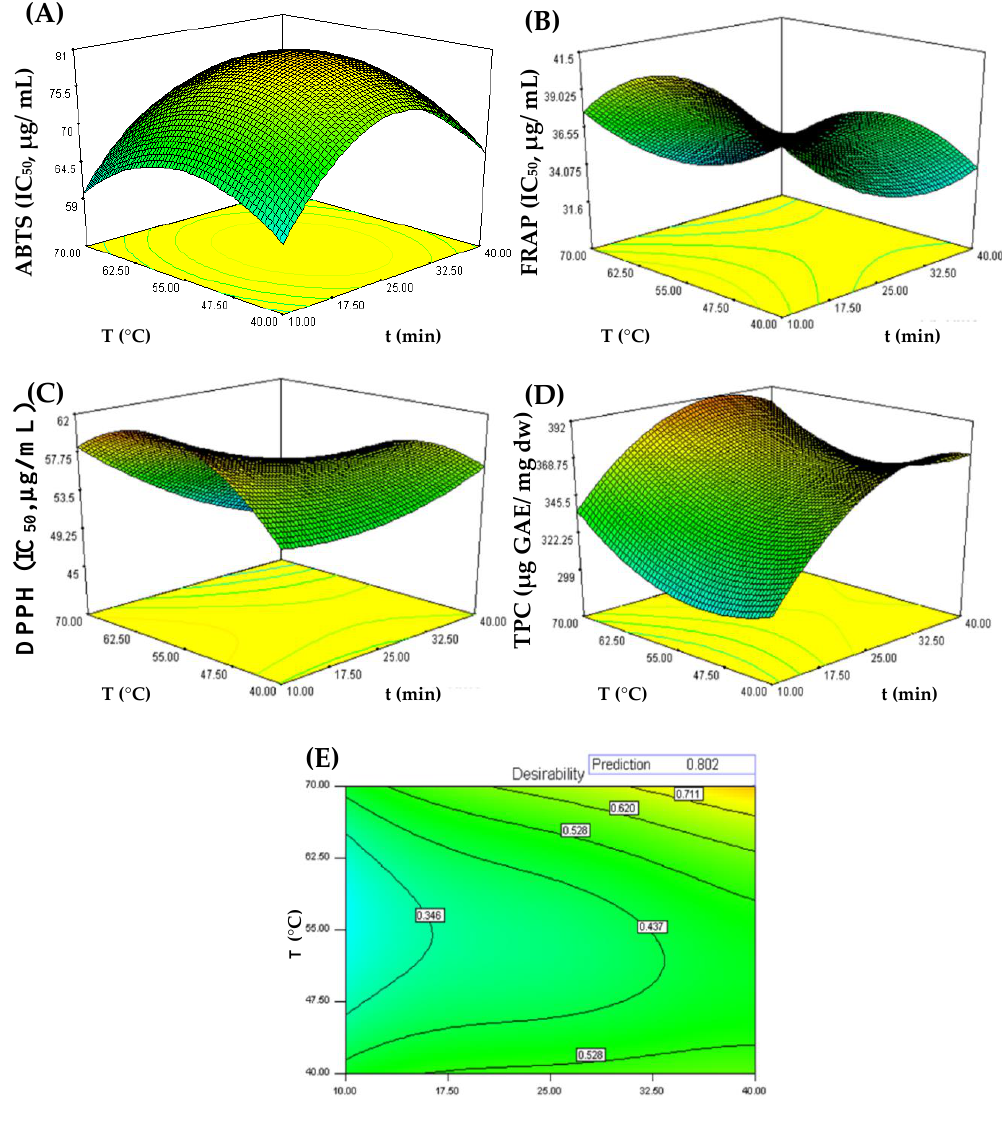
Figure 1. Response surface plots for interaction effects of time (min) and temperature on ABTS ( A ), FRAP ( B ), DPPH ( C ), and TPC ( D ) extraction and on the desirability index for combined responses of UAE-CSS extracts ( E ). The optimal points were identified on the response surfaces.